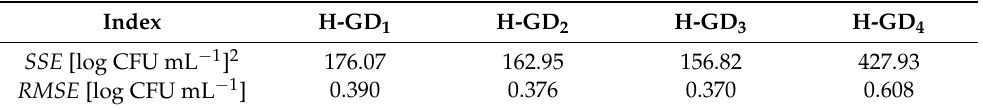
* Parameters optimized by the one-step kinetic data analyses for single cultures. x max is the average value of the maximum bacterial counts for S. aureus (Sa), E. coli (Ec), and Fresco (LAB), respectively. b T and b λ are regression coefficient, T min is theoretical minimum temperature for growth. Table 8. Goodness of fit indexes of the H-GD model cases for growth of a co-culture of S. aureus , E. coli , and Fresco in milk.